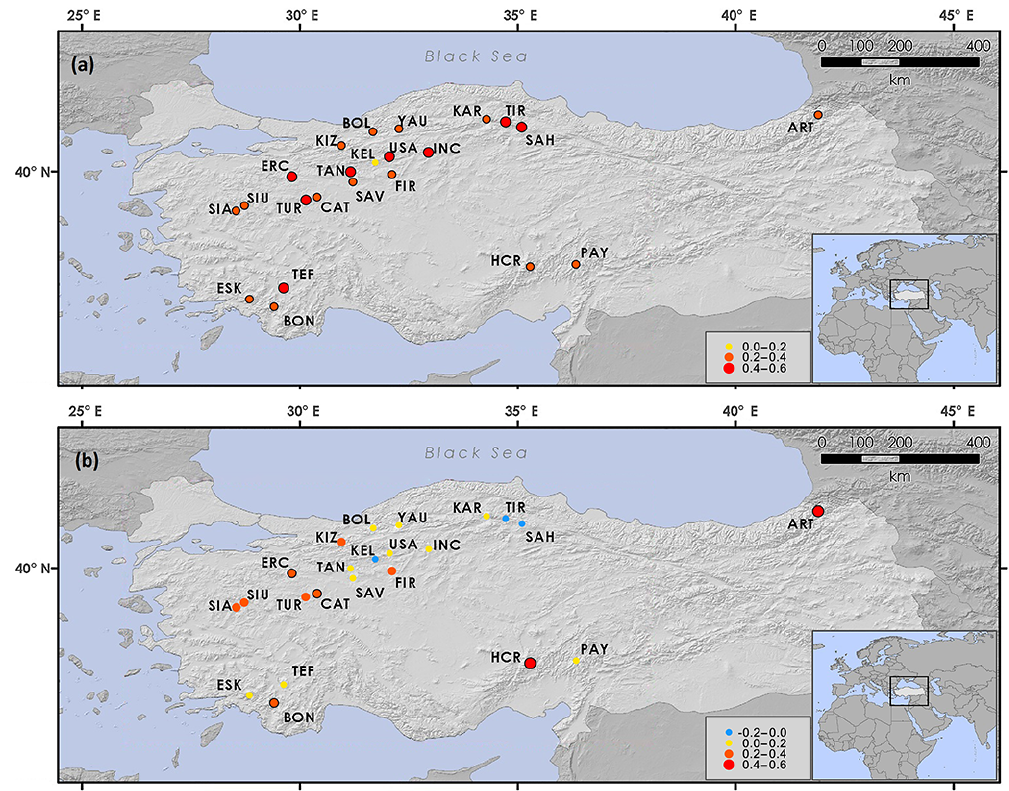
Figure 4. Maps showing Pearson’s correlation coefficients between the sites chronologies and (a) May–August total precipitation and (b) March–April mean temperature for the period 1930–2012. For each site, the closest gridded (0.5 ◦ × 0.5 ◦ ) climate data obtained from CRU dataset were used. Graduated circle size and color correspond to correlation coefficient versus the climate variable. Black lines around circles represent significant correlation coefficients ( p